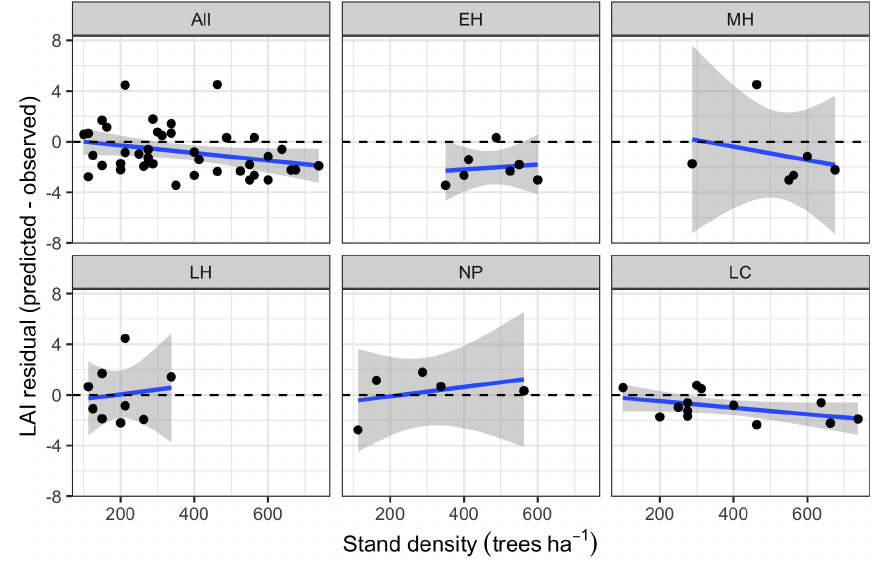
Figure 9. Same as above but as a function of mean site stem